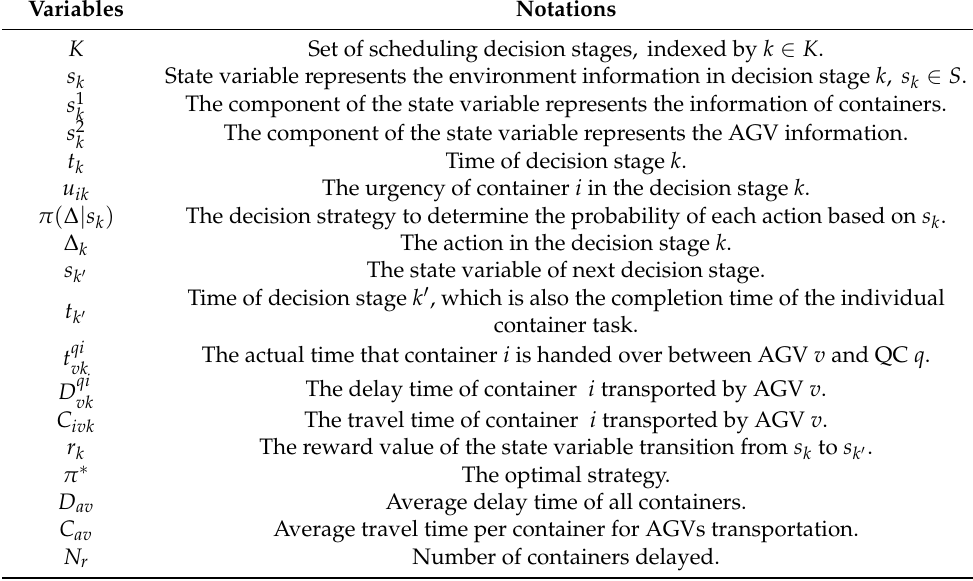
Table 2. Variable